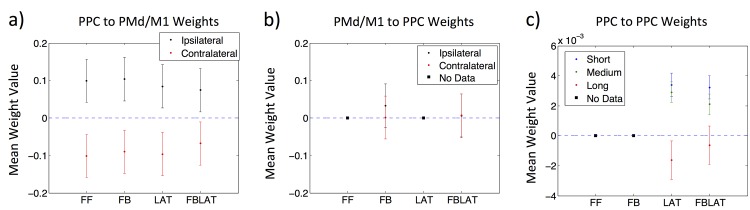
Population Average Connections.The plots show the average weight values per model architecture for feedforward, feedback, and lateral connection sets. In the respective plots, models without the connection set shown are represented by a filled black square (indicated in the Fig. legends) located at a mean weight value of zero. The y-axes show the mean weight value and the x-axes show the model architecture label. The Fig. legends indicate data labels for the respective plots. Error bars show the standard error of the mean (SEM). The dashed line indicates a mean weight value of zero to illuminate differences between excitatory (mean weight value > 0) and inhibitory (mean weight value < 0) weights. a) PPC to PMd/M1 feedforward average ipsilateral vs. contralateral weight values. b) PMd/M1 to PPC feedback average ipsilateral vs. contralateral weight values. c) PPC to PPC lateral average short, medium, and long range weight values.